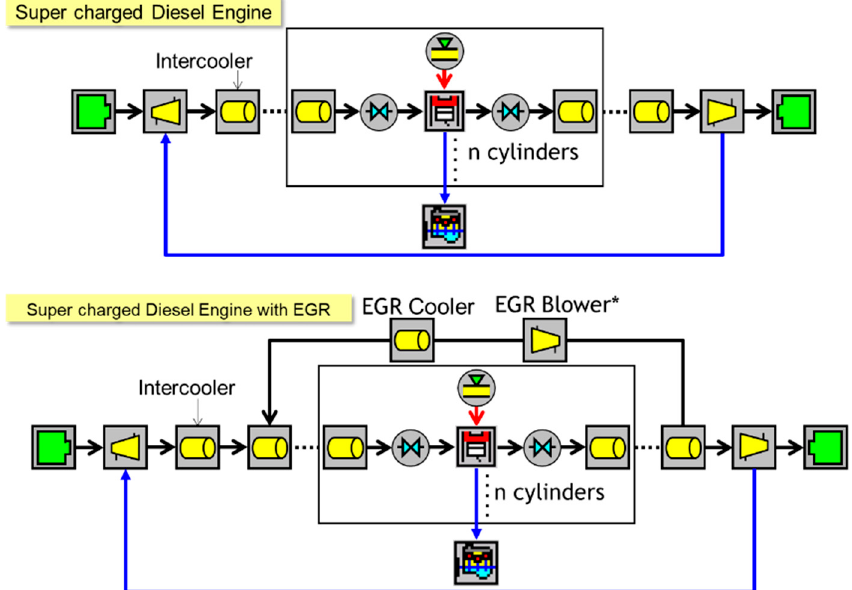
Figure 4. Diesel engine model simulated using G.T. Power (with and without EGR); The ‘EGR Blower*’ has not been applied in this model.